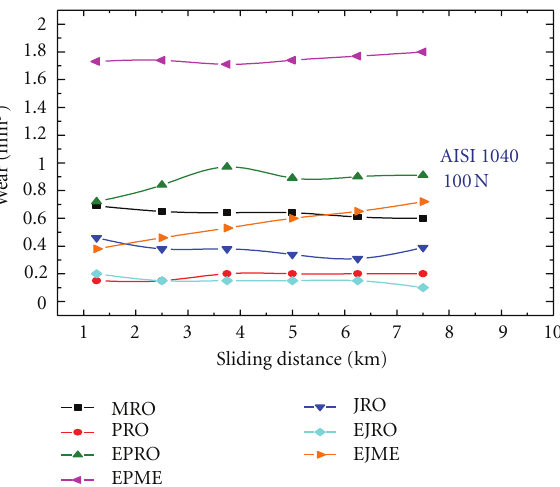
Figure 6: Variation of wear with sliding distance for 100